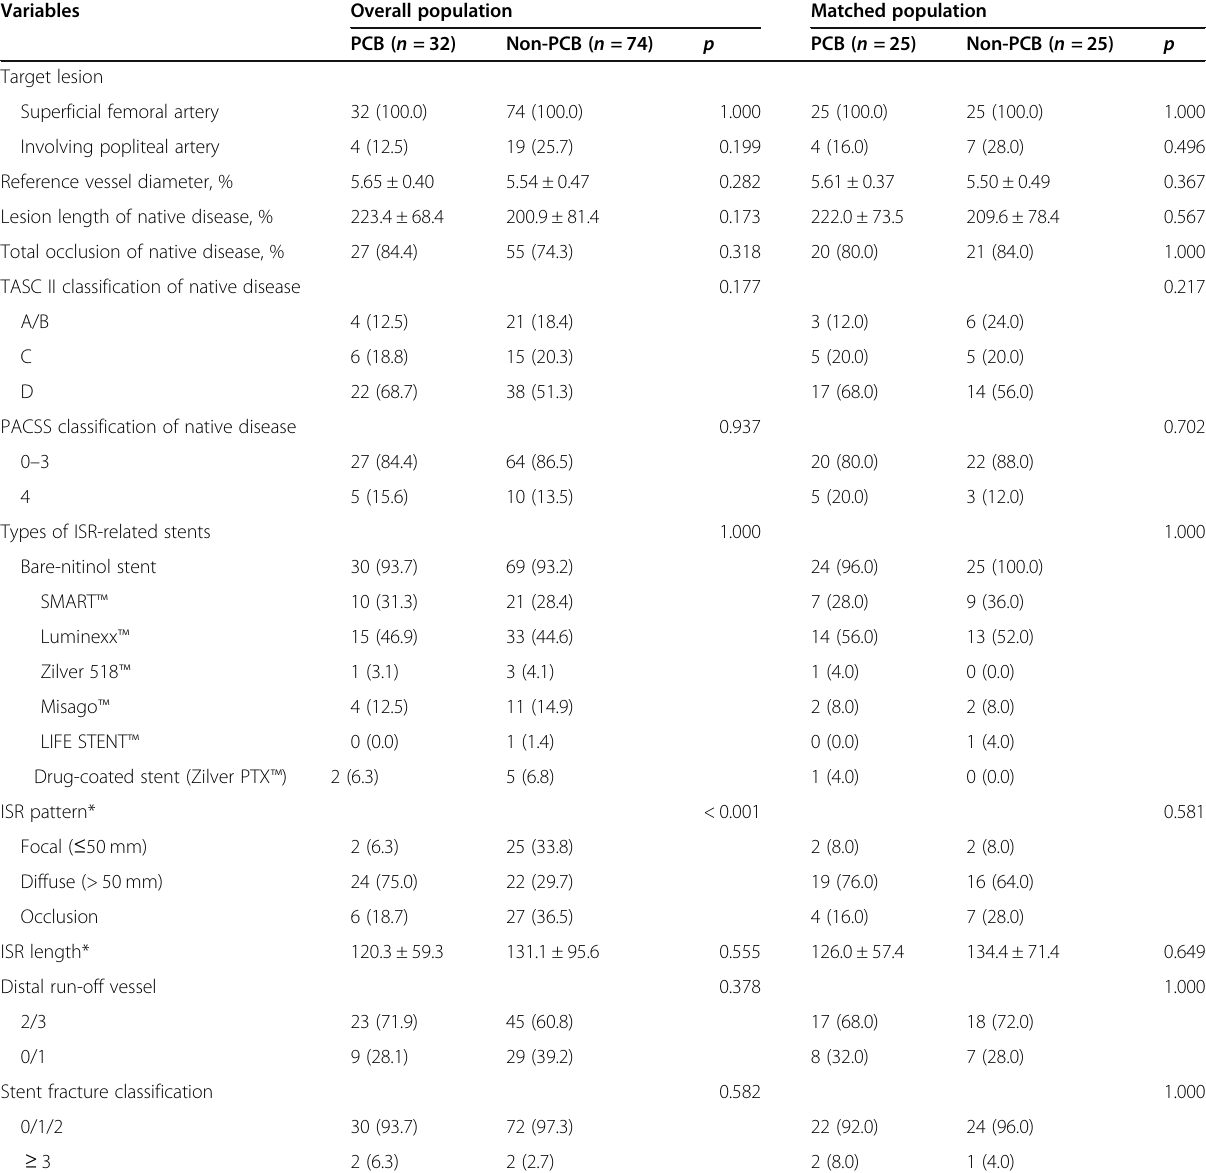
Table 2 Baseline Lesion Characteristics Variables Overall